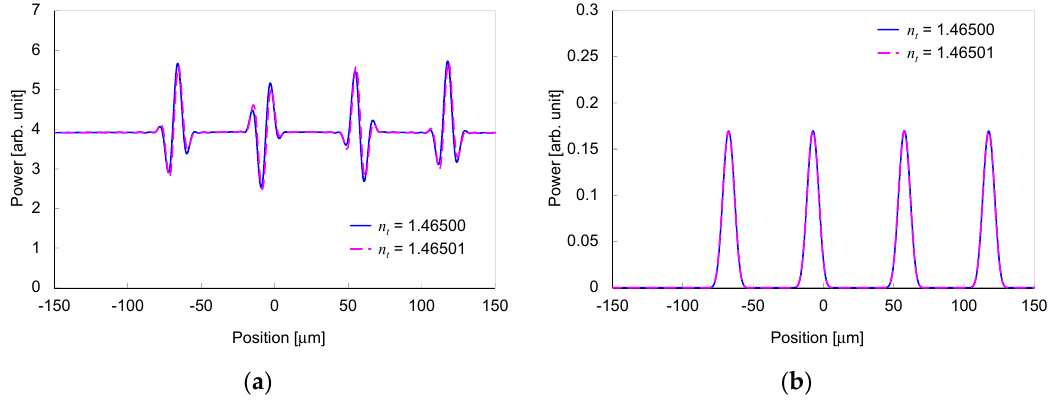
Figure 4. Power distribution at interface between output slab and output waveguides for two values of n t differed by 1 × 10 –5 . ( a ) Proposed structure. ( b ) Structure without broad beam.